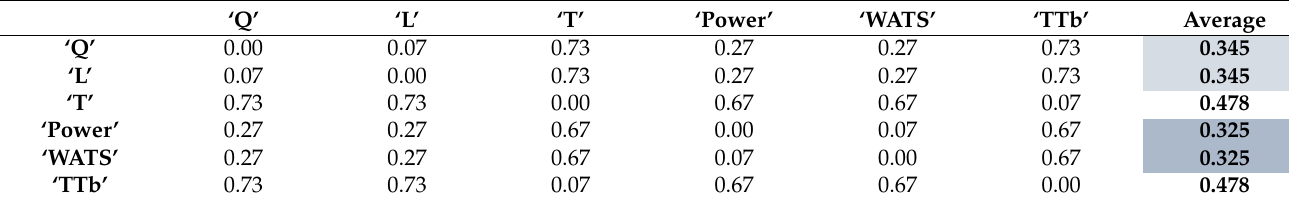
Table 5. Distances between the objectives for Case 1.